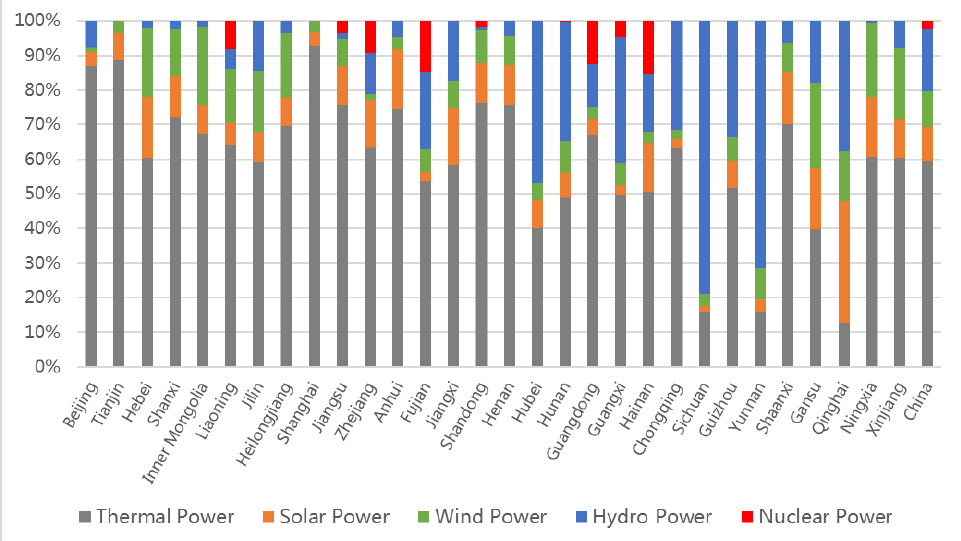
Figure 7. Share of power installed capacity from different primary energies in 2019.